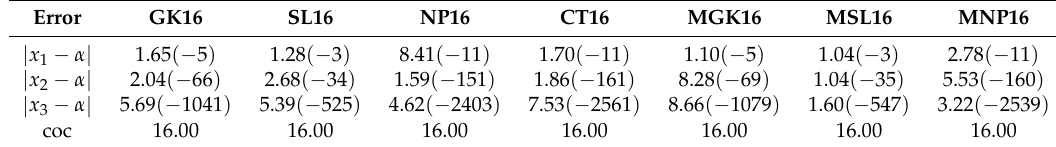
Table 8. Numerical results for f 6 , x 0 = 0.38.